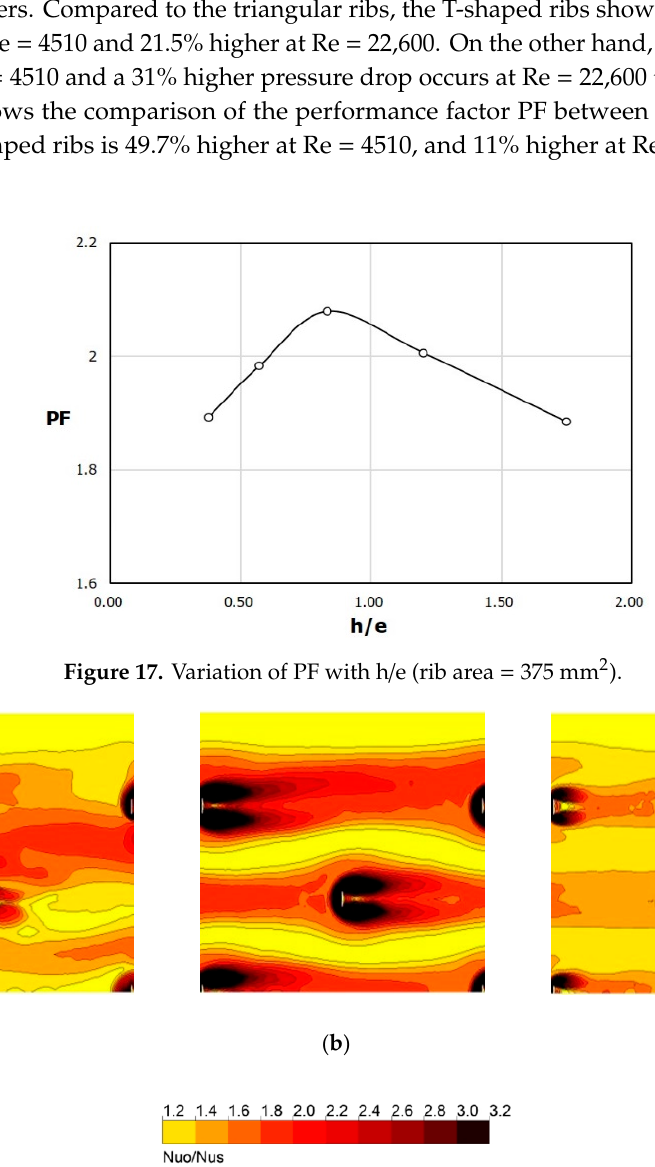
Figure 18. Nusselt number distributions on the heated surface between fifth and seventh ribs for different h/e. ( a ) h/e = 0.38; ( b ) h/e = 0.83; ( c ) h/e = 1.75.